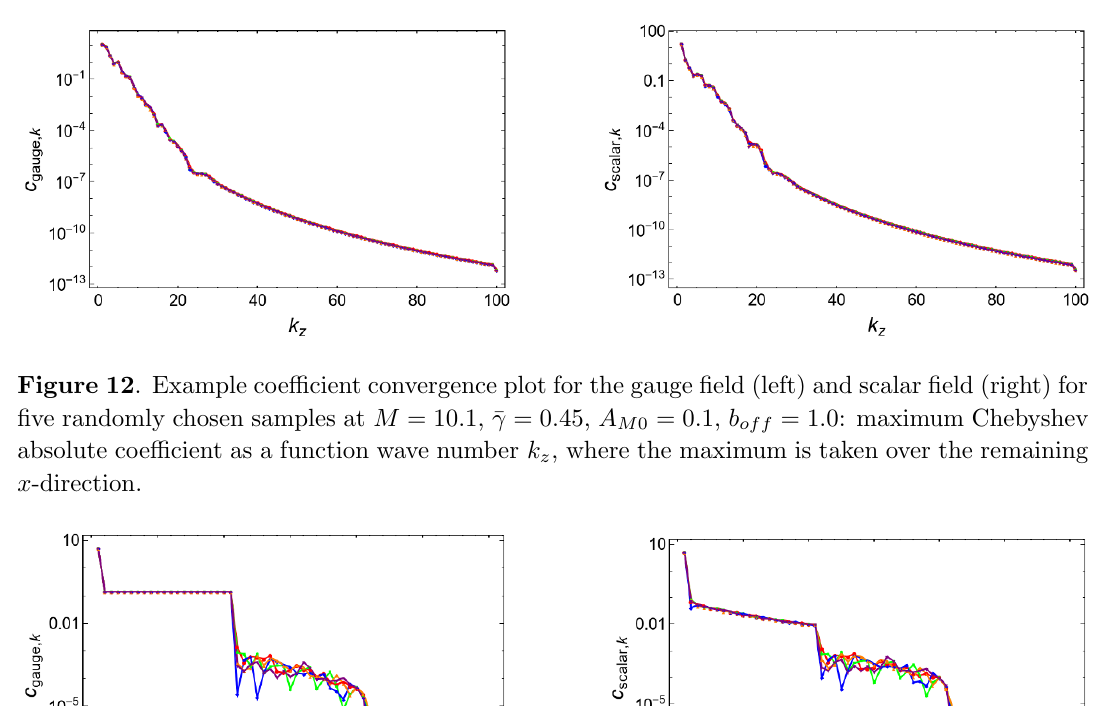
p (cid:11) 2 + (cid:12) 2 (where (cid:11) k and (cid:12) k are the coe(cid:14)cients of k k 2